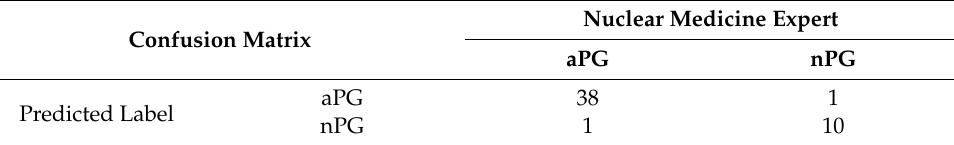
Table 6. Case-to-case comparison between the medical experts’ diagnostic yield and ParaNet for 50 parathyroidectomy-confirmed